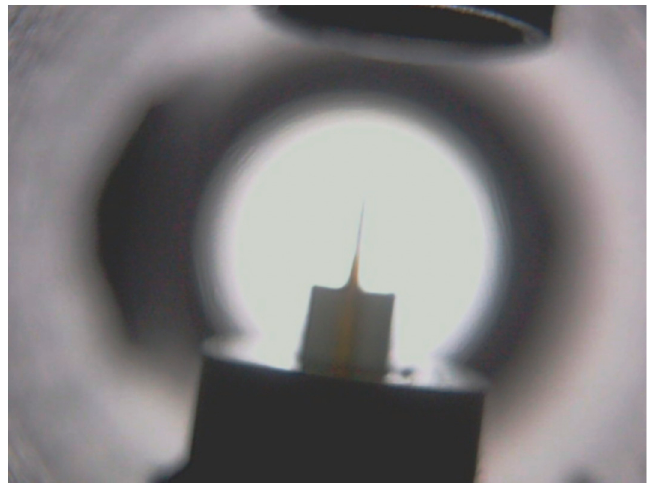
Figure 2. Inside of the electrospray chamber. The tip of the quarz-capillary is seen in the center.